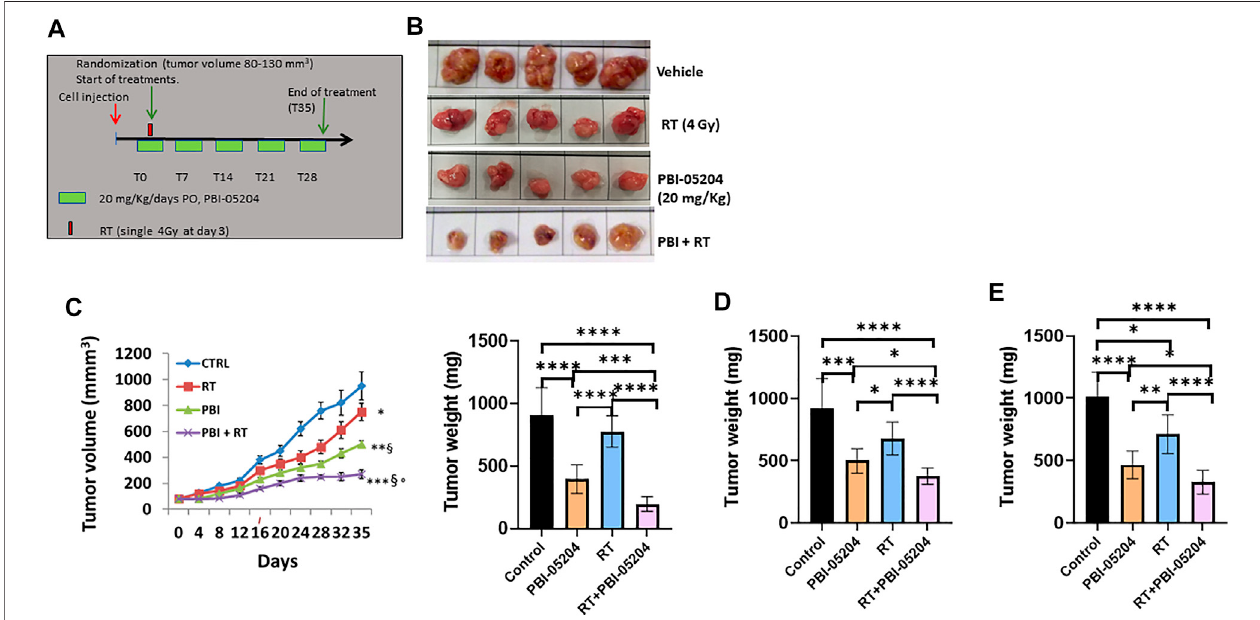
FIGURE 7 | PBI-05204 modi fi ed the responses of RT in human GBM cells mouse xenograft models. (A) Schematic representation of the treatment schedule of PBI-05204(20 mg/kg/day)administered withasingledoseofRT(4 Gy)atday3followingstartoftreatment. (B) RepresentativeU87MGtumorsexcisedafter35 days(5 tumors/group). (C) Graphical representation of tumor growth curve and terminal tumor weight evaluation of U87MG tumors. (D) Graphical representation of terminal tumor weight of U251 tumors. (E) Graphical representation of terminal tumor weight of TG98 tumors treated with RT, PBI-05204 (20 mg/kg) and RT plus PBI- 05204. Data are presented as mean ± SD. * p < 0.05, ** p < 0.01, *** p < 0.001, **** p < 0.0001, δ p < 0.01 vs RT, and ° p < 0.05 vs PBI-05204.